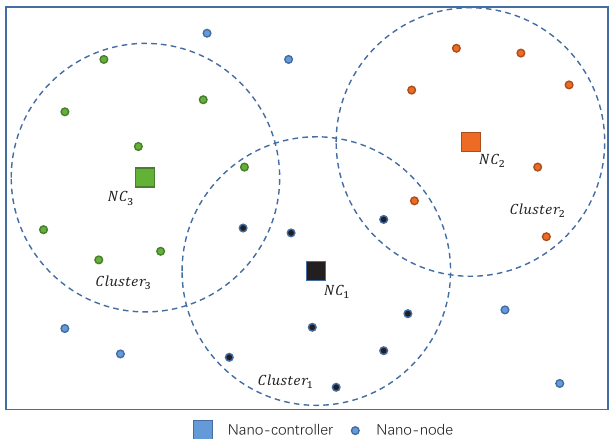
Figure 2. An example of centralized nano-network.